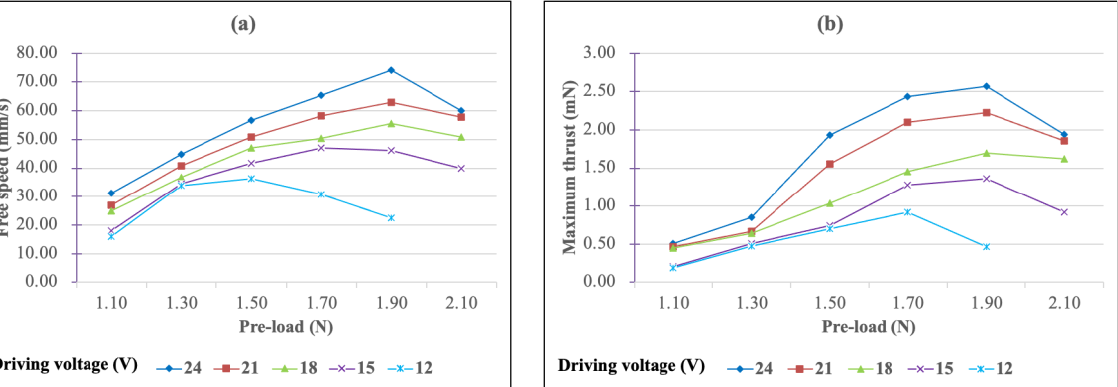
Figure 16. ( a ) Free speed and ( b ) maximum thrust figures as a function of the pre-load for the multi-layer bimorph USM under different driving voltages.